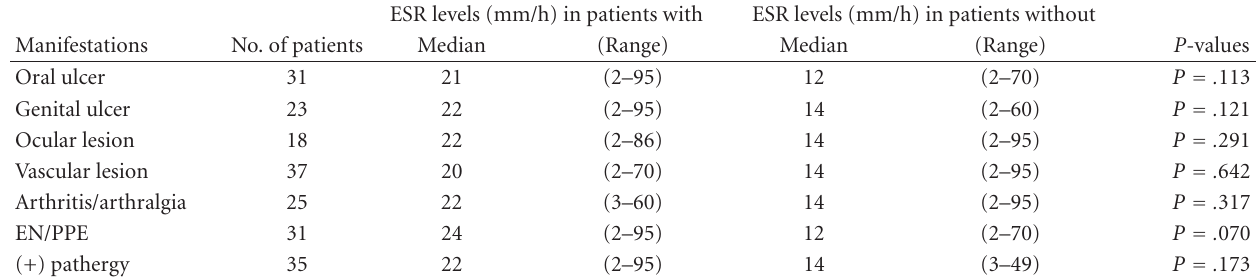
Table 6: The significance of the association of ESR with versus without individual clinical manifestations and pathergy reaction. ESR levels (mm/h) in patients